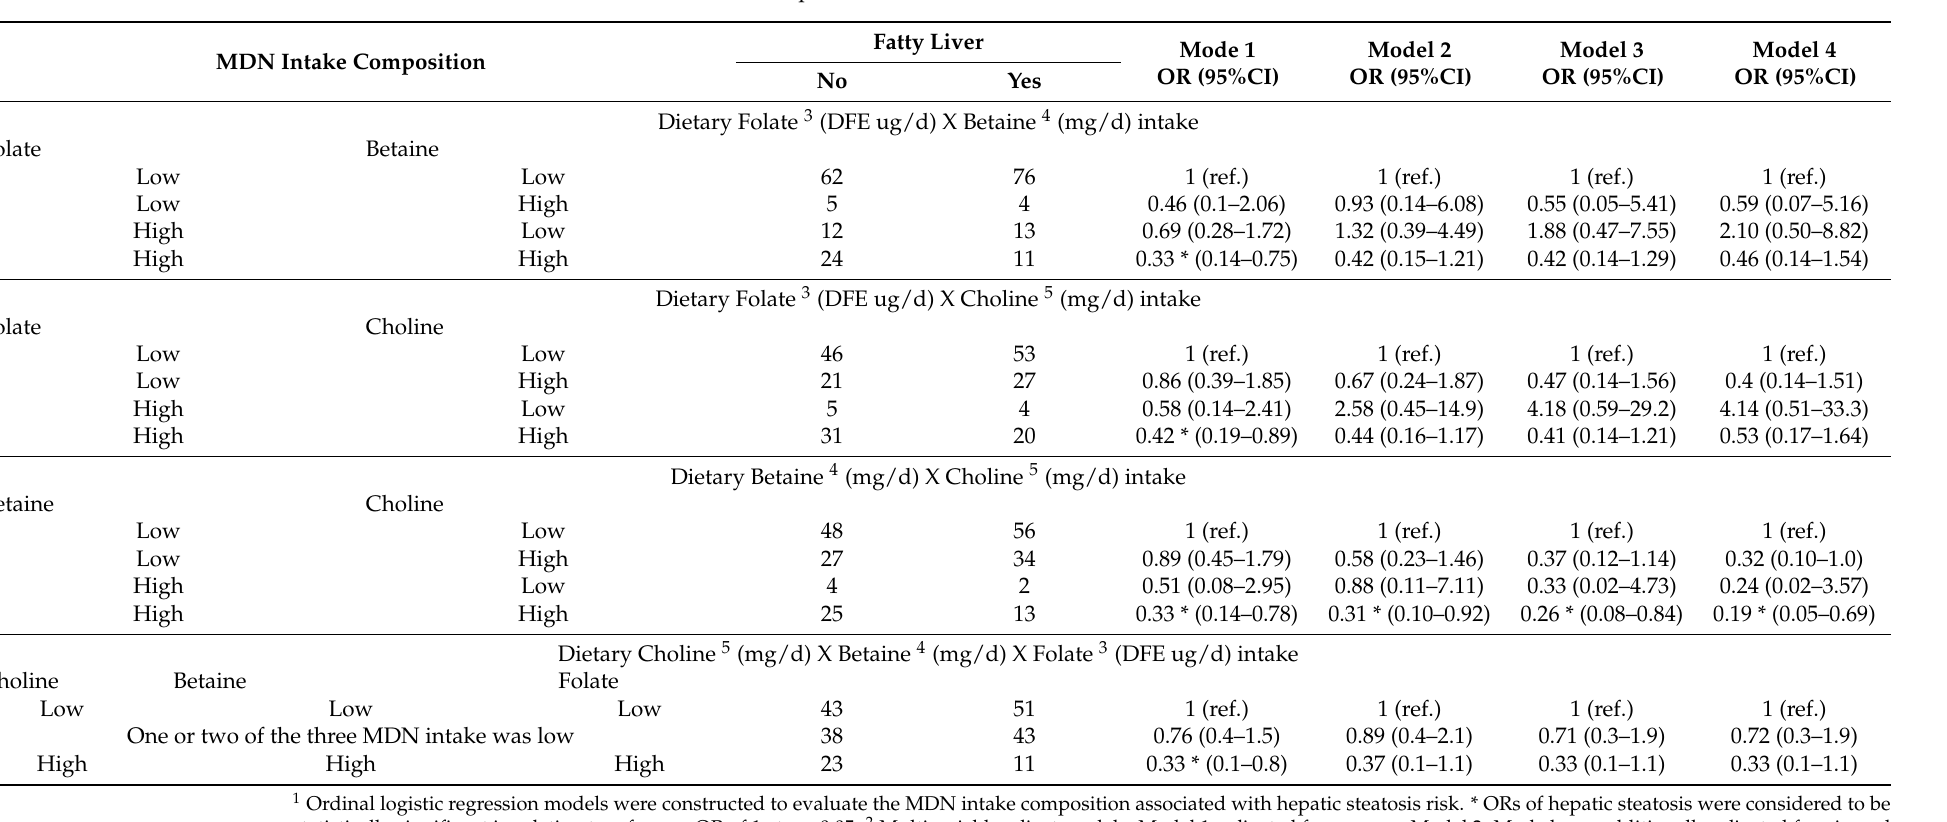
Table 5. Association of combined MDN intake composition with VOB-related HS risk 1,2